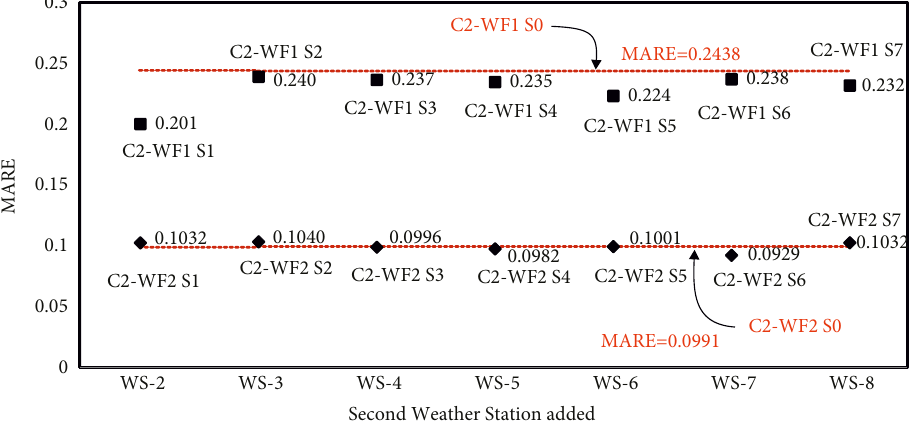
Figure 9: Comparison of the “MARE” results for Case 2 and Case 1 (C2-WF S0).